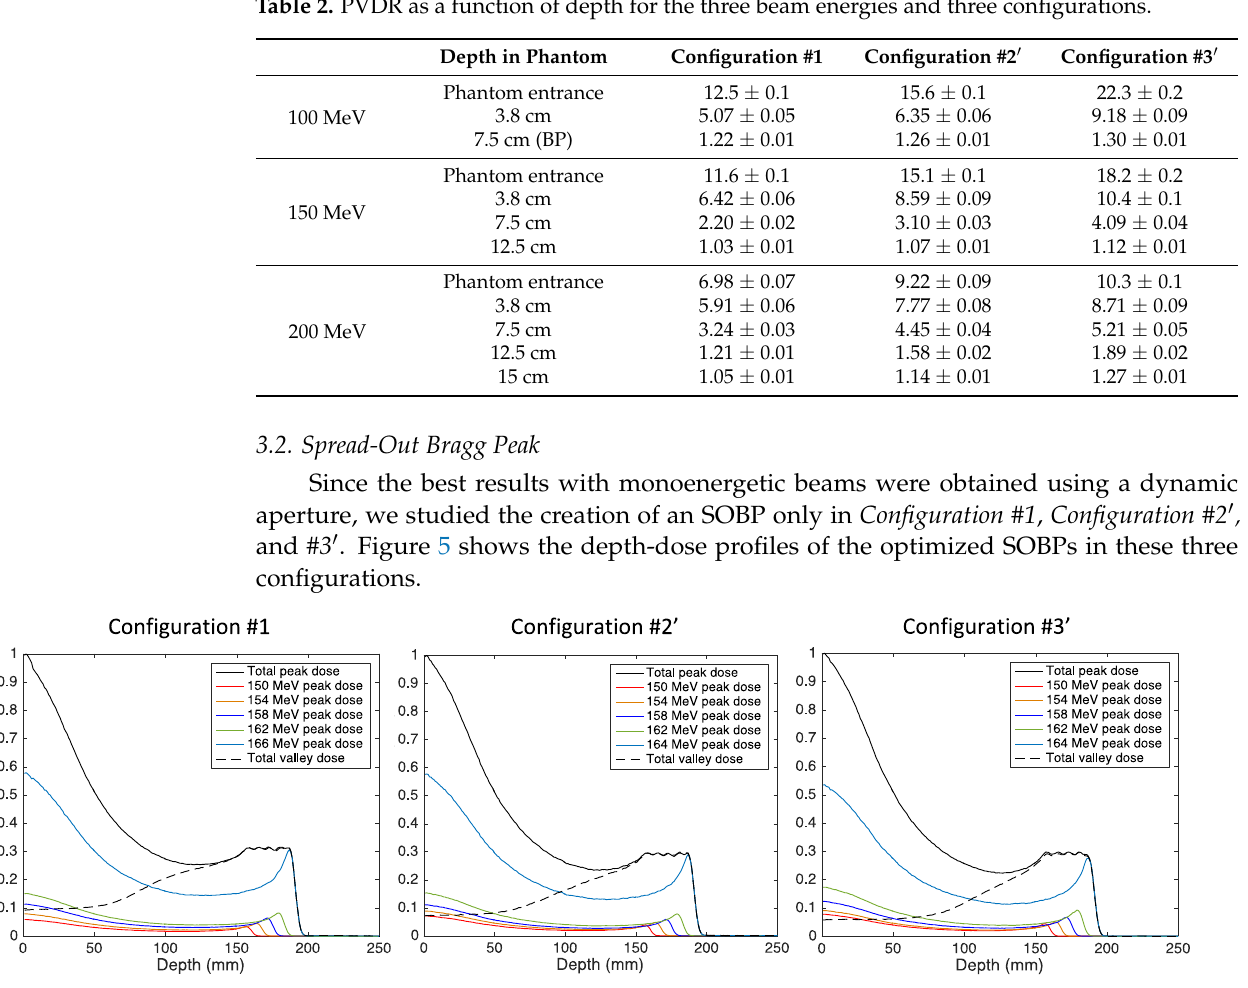
Figure 5. Optimized spread-out Bragg peak in the three configurations. The figure shows the contributions of the individual Bragg peaks (colored continuous lines) to the total peak dose (black continuous line) on the central minibeam axis as well as the valley dose on the first central valley (dashed black line).